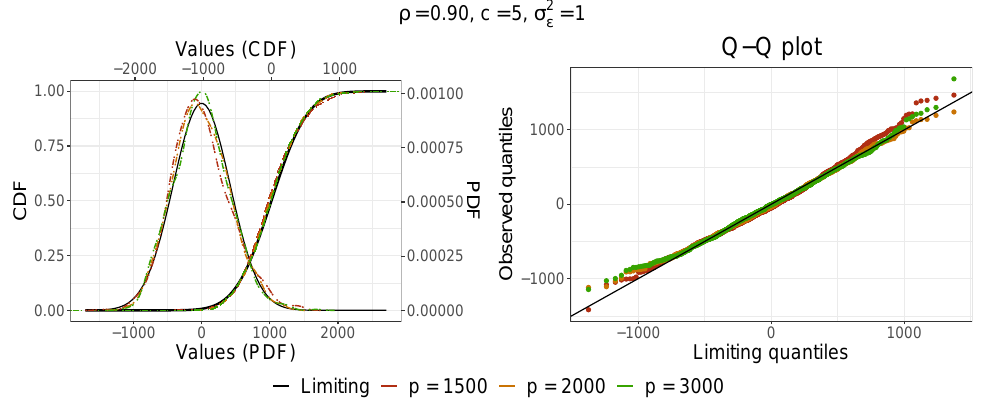
Figure 7. Comparison of the PDF and CDF ( left ) and the corresponding Q-Q plots ( right ) after 1000 replications from the Monte Carlo simulation of the statistic (80) with the limiting distribution N ( 0, s 2 ) by the Corollary 2 (in black) for (cid:36) = 0.9, c = 5, σ 2 = 1 and p = ε